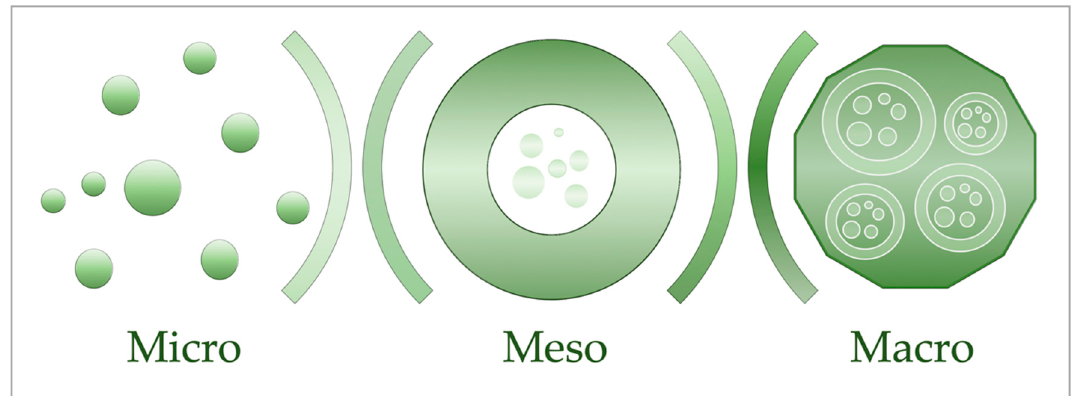
Figure 3. Visualization of micro, meso, and macro levels of analysis. Source : Author creation.